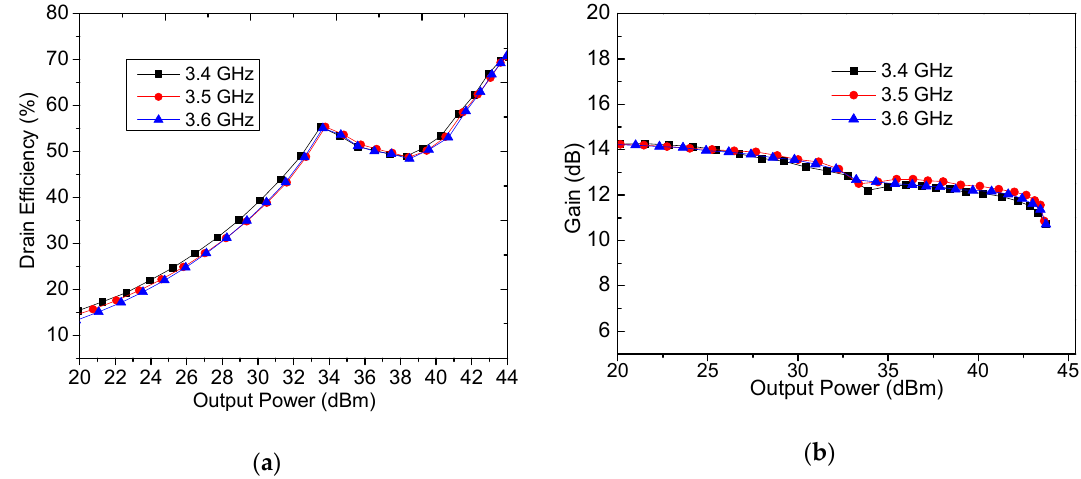
Figure 17. Measured drain efficiency, gain, and power added efficiency (PAE) versus output power: ( a ) drain efficiency, and ( b ) gain.